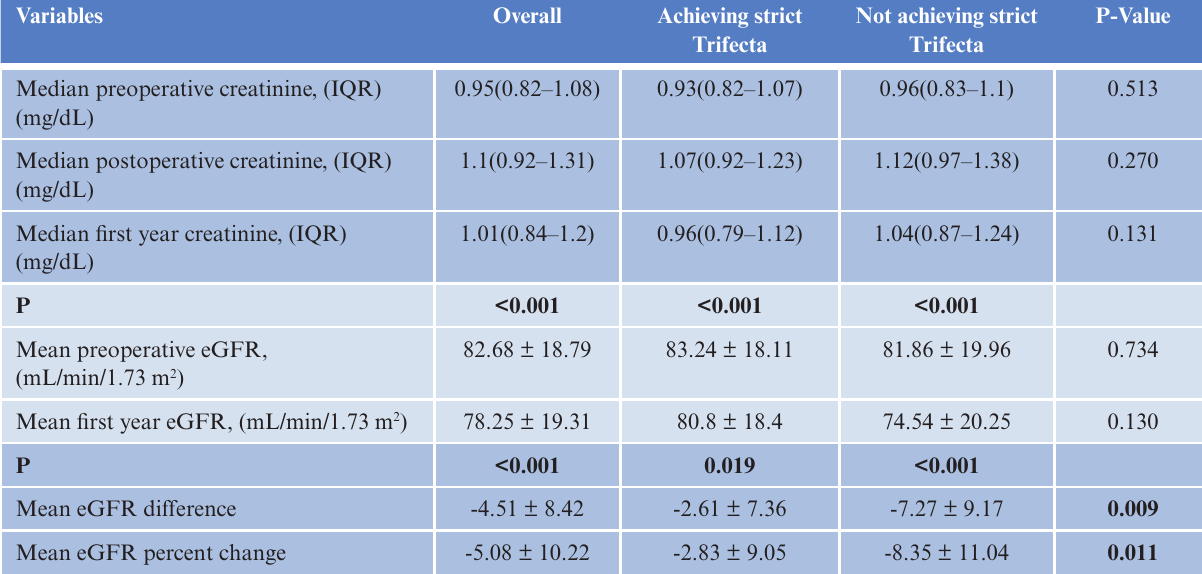
Table 4: Preoperative and postoperative renal functional